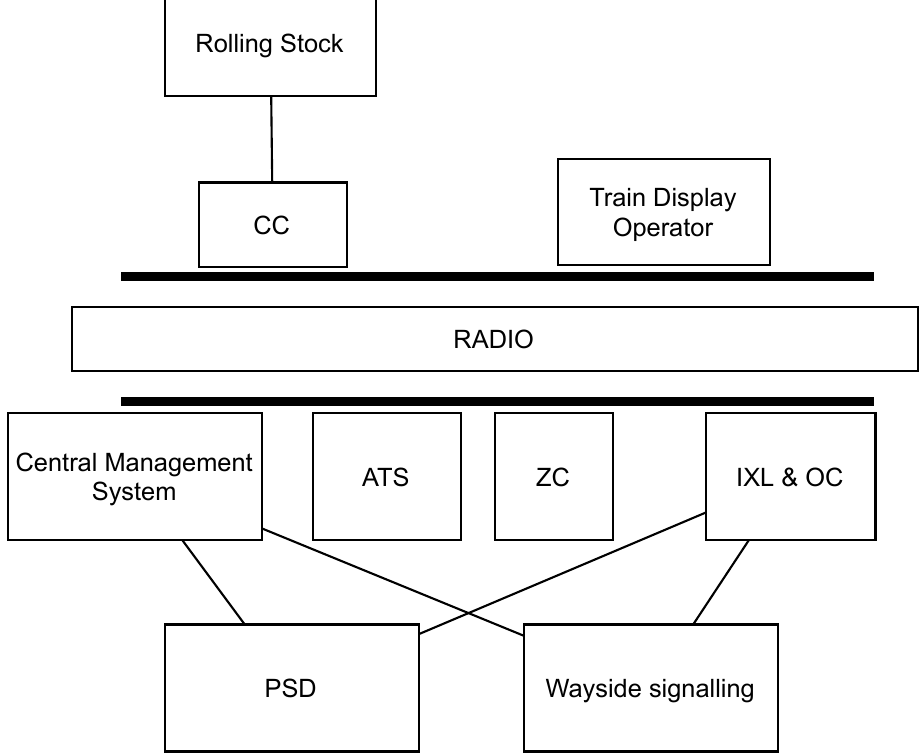
Figure 13. A reference architecture for